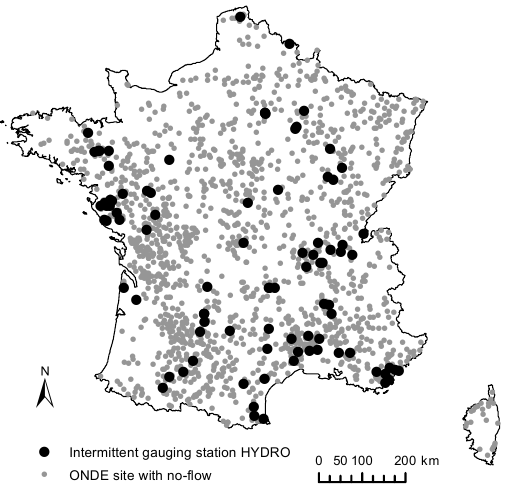
Figure 6. Map of ONDE sites and HYDRO gauging stations with at least one